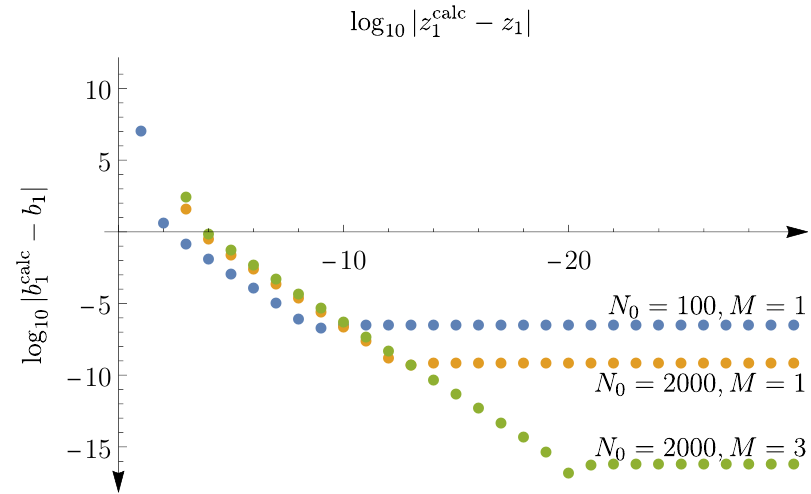
Figure 4. Error in the calculated coefficient | b calc − b 1 | as a function of the error in the branch 1 point position | z calc − z 1 | for the following three choices of parameters: N 0 = 100 , M = 1 (in blue), 1 N 0 = 2000 , M = 1 (in orange) and N 0 = 2000 , M = 3 (in